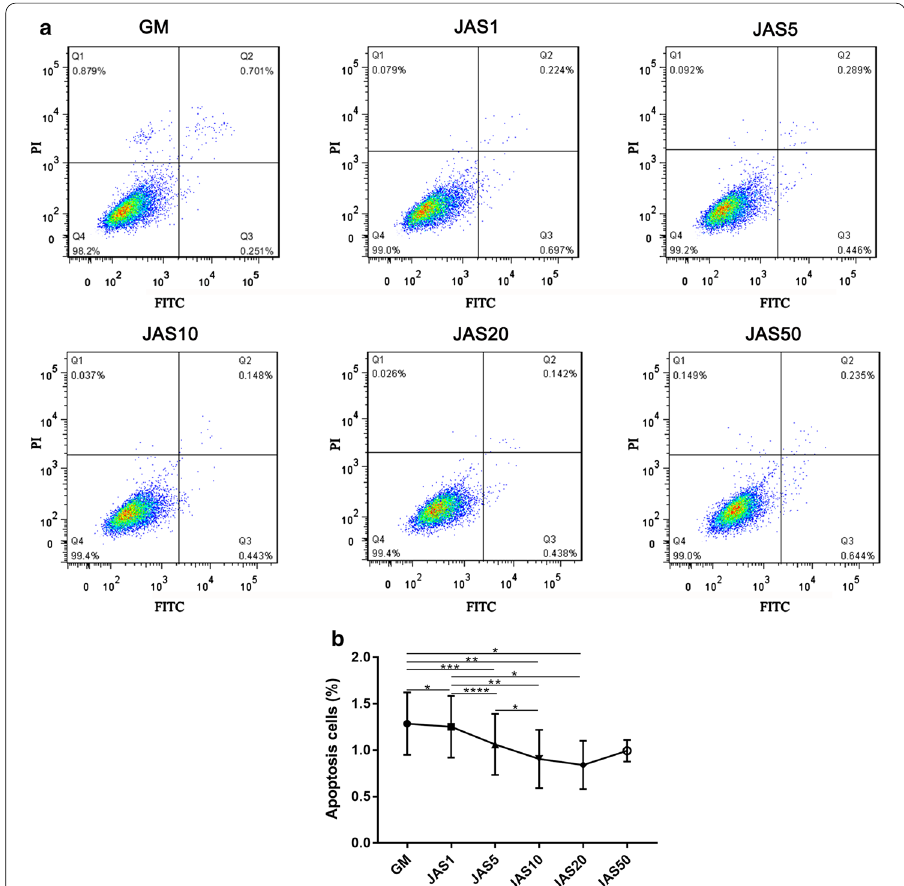
Fig. 2 Flow cytometry analysis of the effects of different actin polymerization states on hASC apoptosis. Cell apoptosis was examined by Annexin V-FITC/PI staining. hASCs were treated with JAS for 7 days a , and the expression of fluorescence was detected using flow cytometry and analyzed with FlowJo